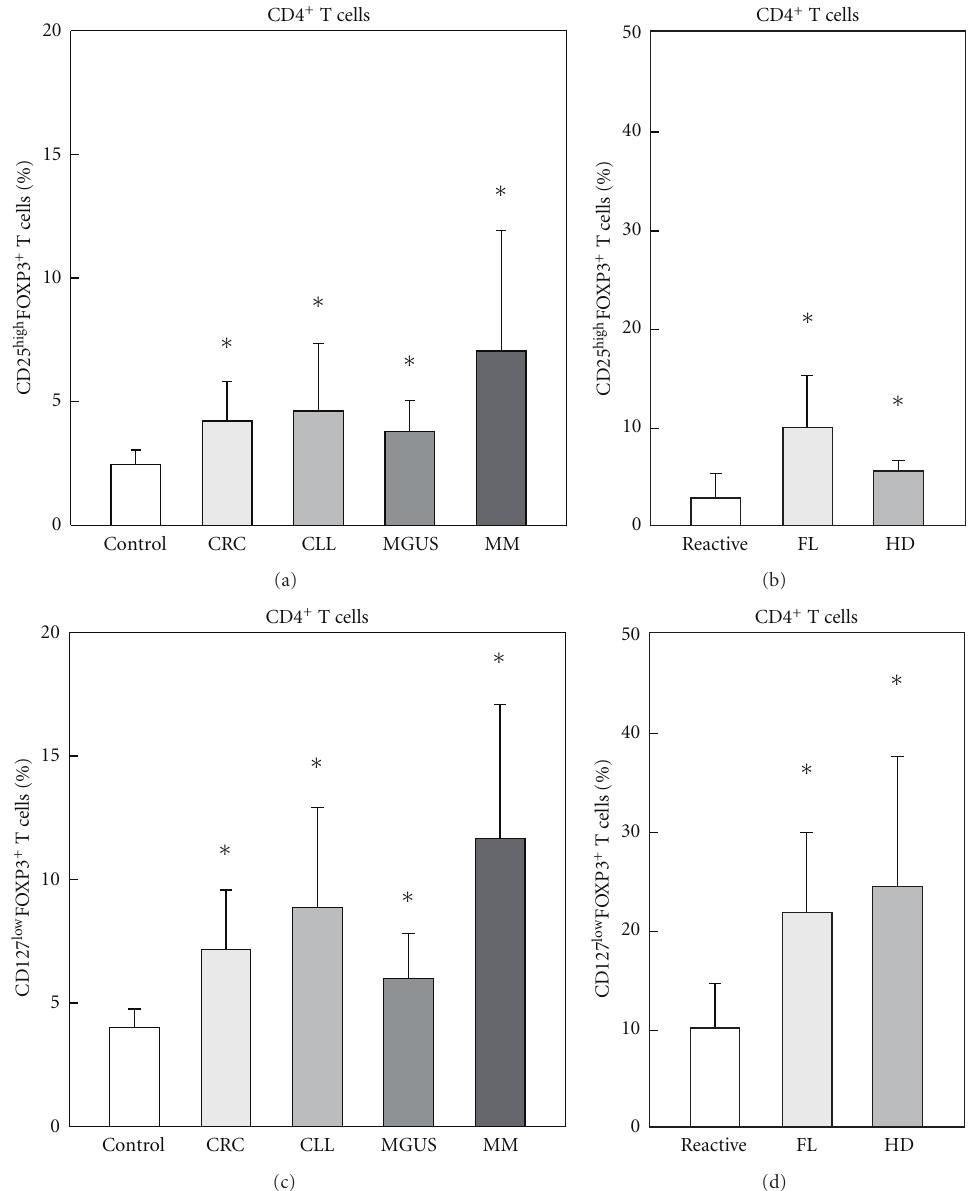
Figure 3: Assessment of T reg -cell frequencies. Frequency of CD4 + CD25 high FOXP3 + T reg cells in (a) peripheral blood of 10 healthy donors (control), 12 colorectal cancer (CRC), 10 CLL, 7 MGUS, and 10 multiple myeloma (MM) patients and (b) 7 reactive lymph node biopsies from healthy individuals (reactive), 7 patients with follicular lymphoma (FL), and 6 patients with Hodgkin’s disease (HD). (c) and (d) Frequencies of CD4 + CD127 low FOXP3 + T reg cells in the respective groups. Error bars represent standard deviation ( ∗ , P < 0 . 05, Student’s t